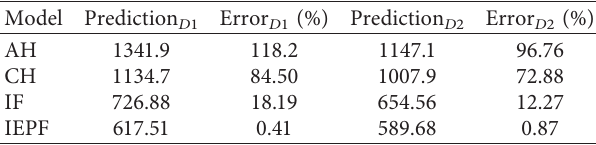
Table 20: Ultimate bearing capacity prediction for example